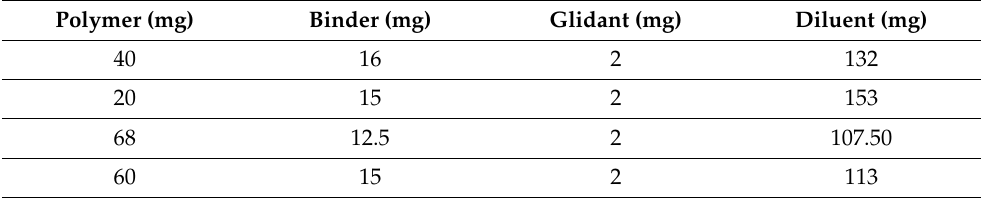
Table 2. Composition of sustained-release